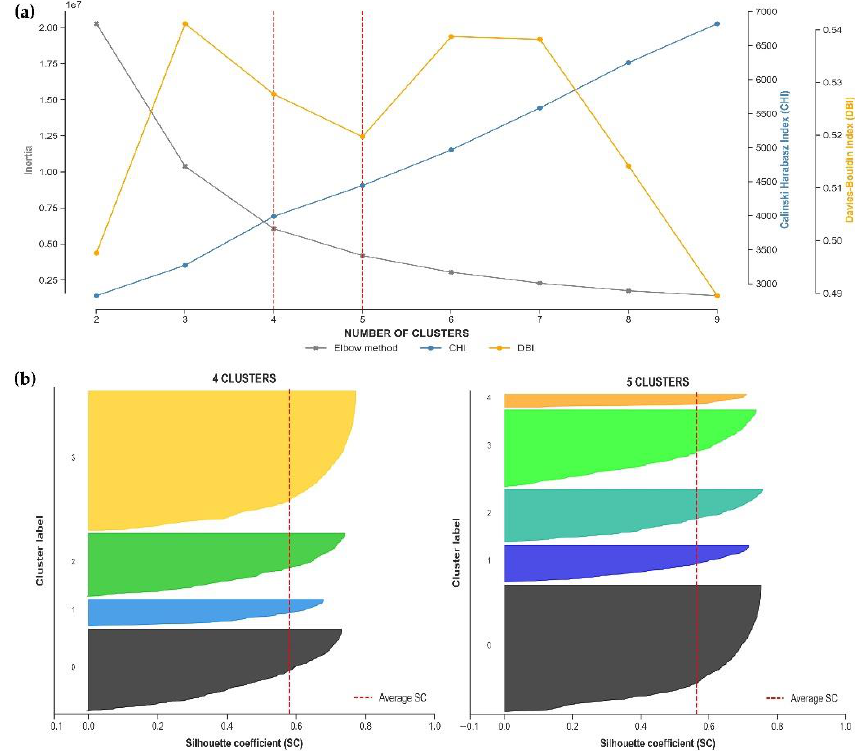
Figure A3. Cluster metrics for R-factor calculated by the RUSLE2 methodology including ( a ) CHI, DBI, the elbow method and ( b ) the silhouette score coefficient.